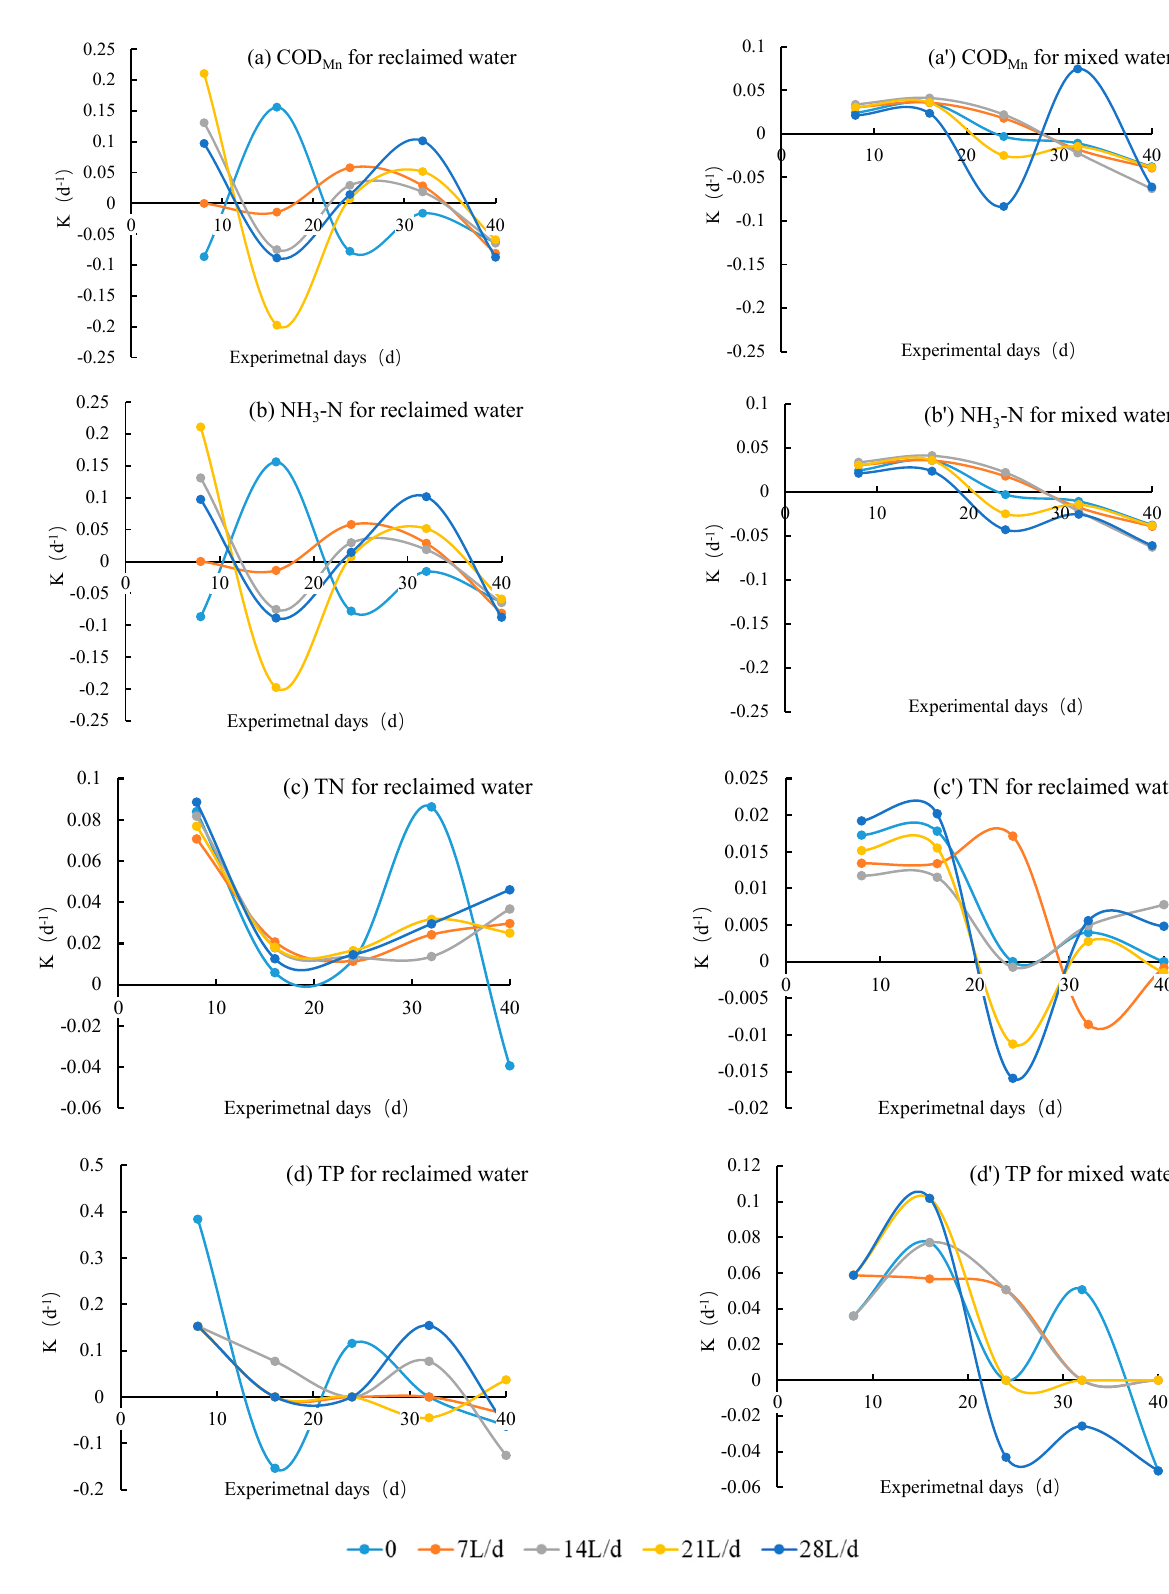
Figure 4. Dynamics of degradation coefficient ( K ) in CODMn, NH3–N, TN and TP with the experimental processes. for different exchange flow rates (( a – d ) for the reclaimed water and ( a’ – d’ ) for mixed water)